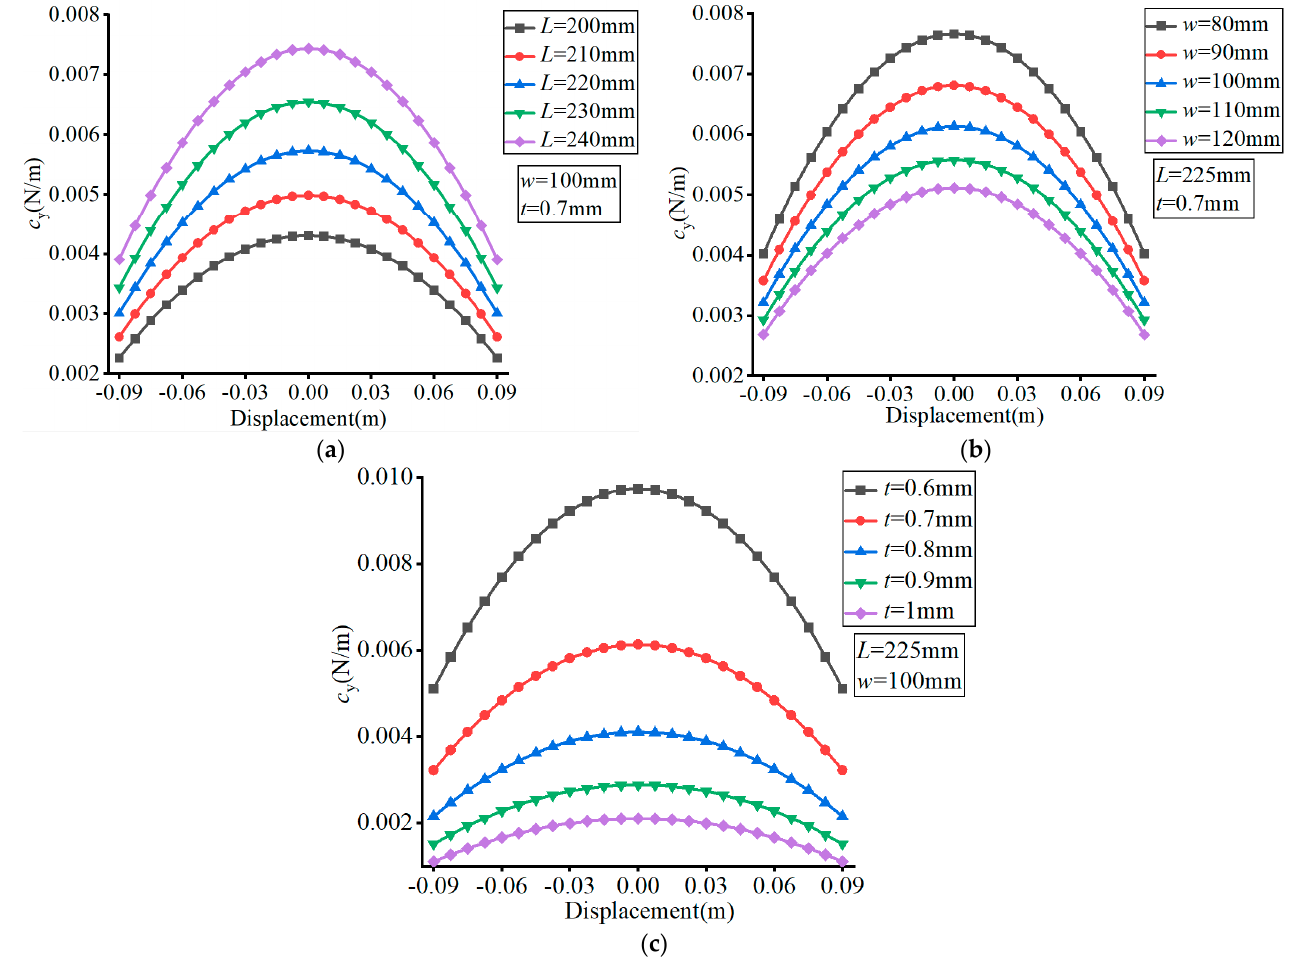
Figure 5. Effect of structural parameters on c y . ( a ) Effect of L ; ( b ) Effect of w ; ( c ) Effect of t .